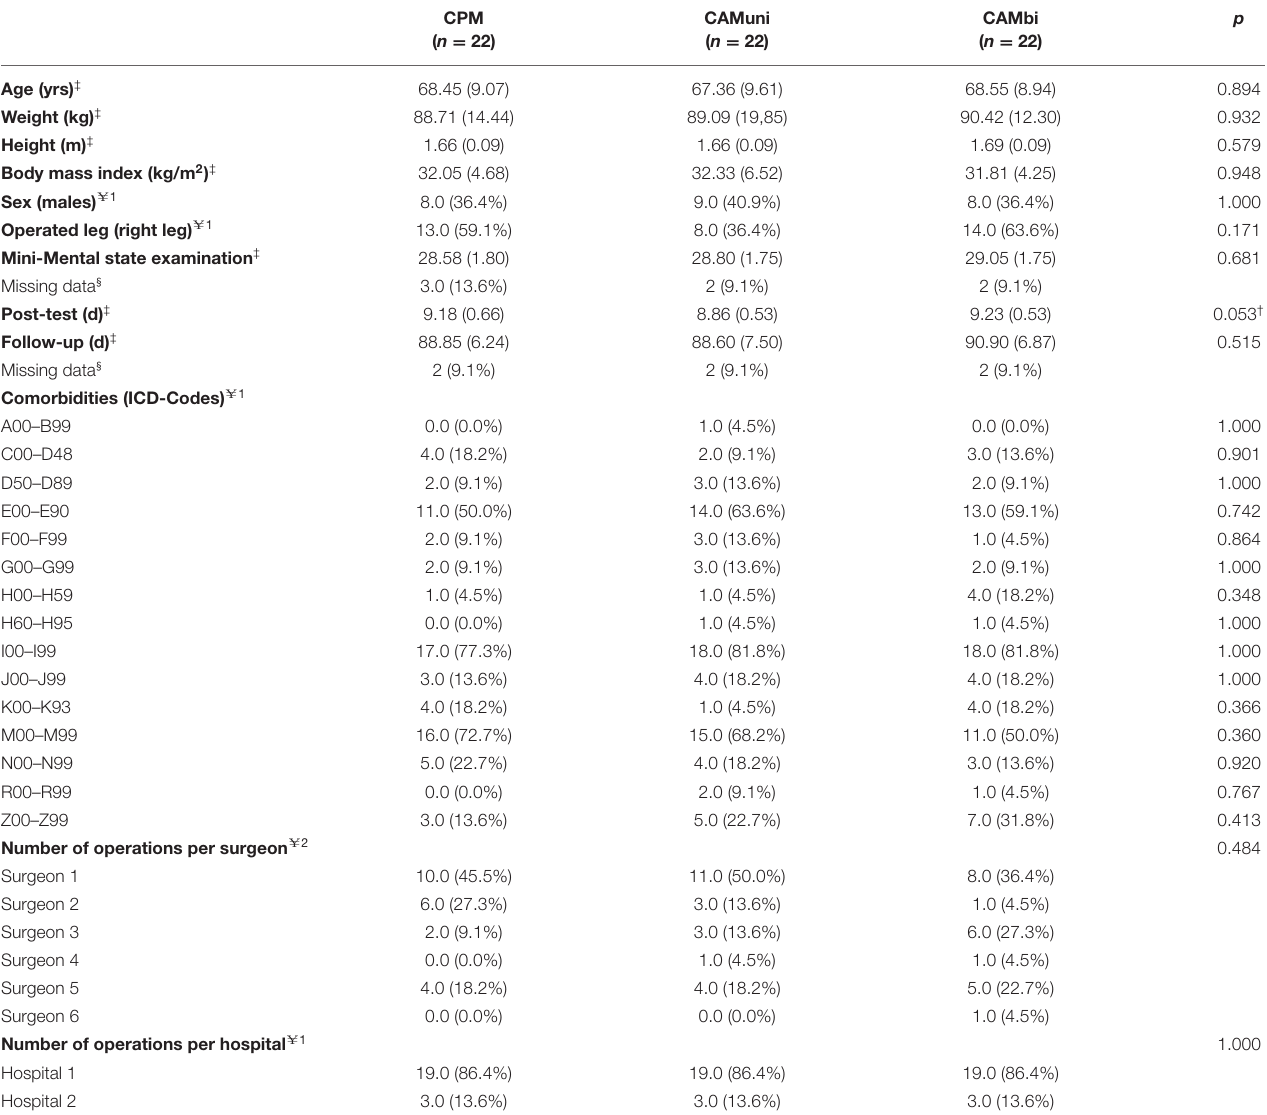
TABLE 1 | Demographic and clinical subject